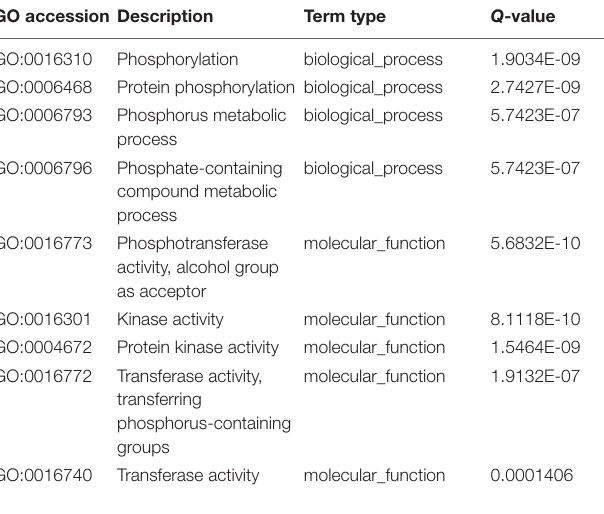
TABLE 2 | Significant Gene Ontology (GO) terms of over-dominance at the seedling and flowering